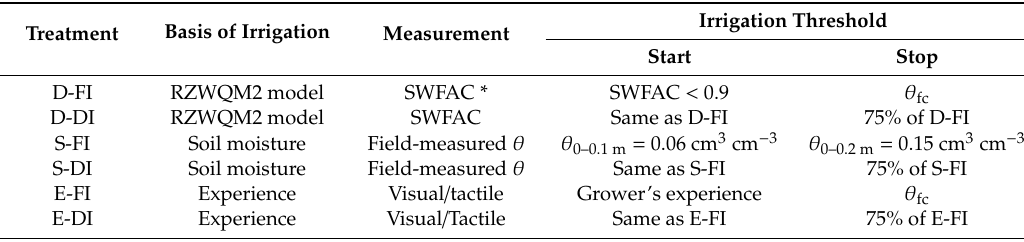
Table 1. Experimental treatments